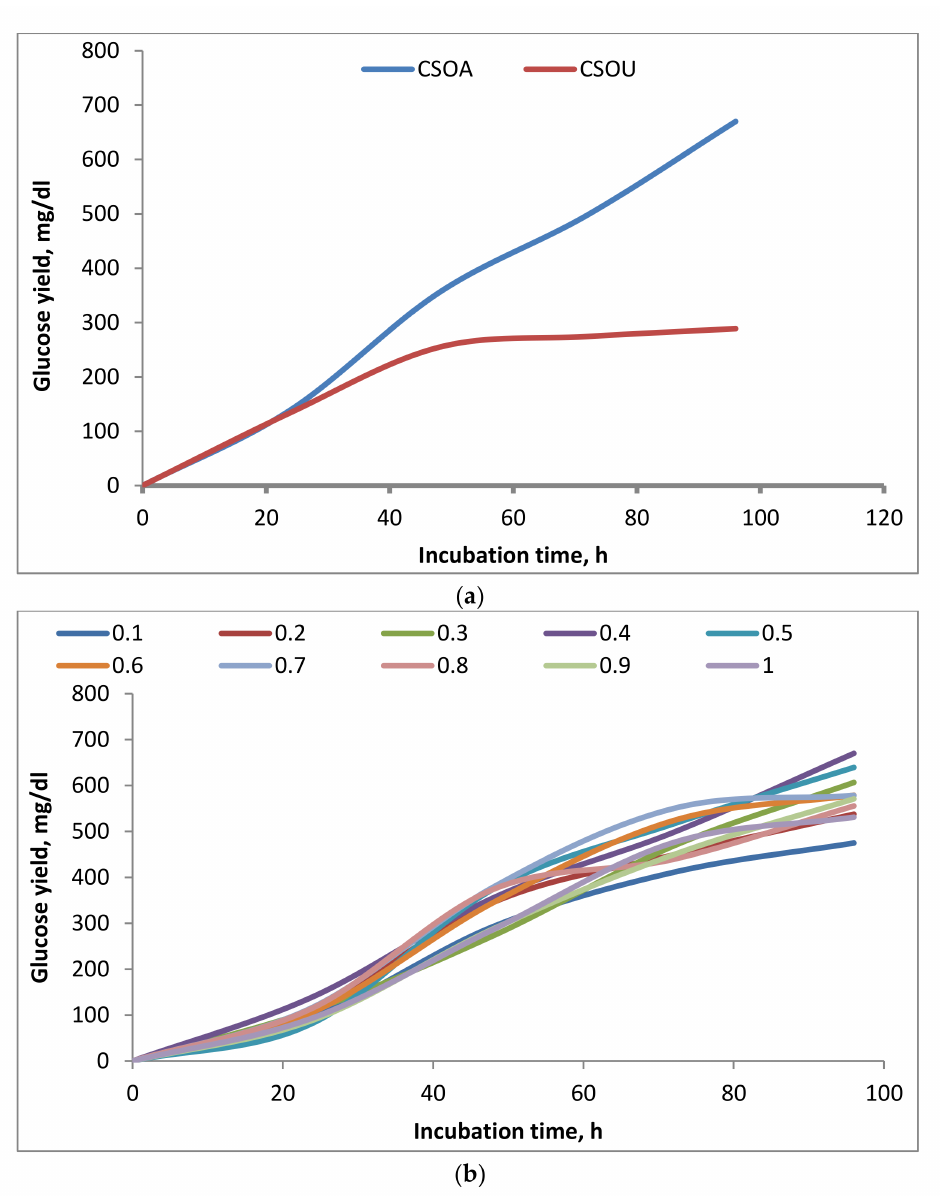
Figure 6. ( a ) Effect of physical pretreatment on the enzymatic saccharification, and ( b ) effect of enzyme dosage on the enzymatic saccharification